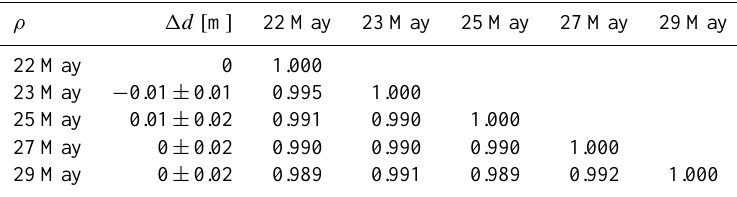
Table 2. Assessment on the stability of the estimated reflector depths via statistical analysis. 1d is the average difference of the estimated reflector depths relative to the values measured on 22 May. ρ is the correlation coefficient between the reflector depths measured at the given times. ρ 1d [ m